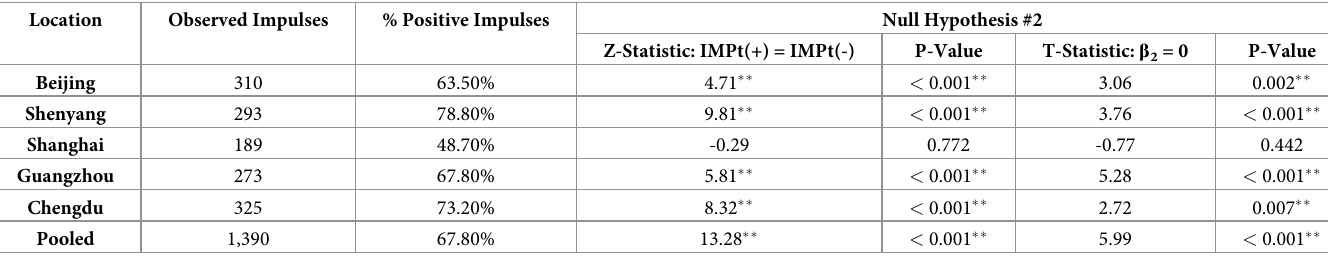
equal While a higher-than-expected frequency of impulses can signify a non-random data genera- tion process, the signs associated with β also contain important information about how they 2 are generated. If random chance generates the impulses, the number of positive and negative impulses should be roughly equal. The specification of Eq (2) makes β > 0 when measurements 2 at stations controlled by the Chinese government are significantly lower than the value implied by the corresponding measurement at the U.S. embassy-controlled station. In the pooled sam- ple (and in four of the five individual cities), more than 63% of the observed impulses are posi- tive. A z-statistic (Table 2) indicates that, for the pooled model and all individual cities except for Shanghai, it is highly unlikely (p < 0.01) that random chance generates the preponderance of positive impulses. This result is confirmed by a two-tailed, one sample t-statistic (Table 2) which evaluates the null hypothesis that the mean coefficient value of significant impulses is Table 2. Test of null hypothesis #2 for the five Chinese cities and pooled model.